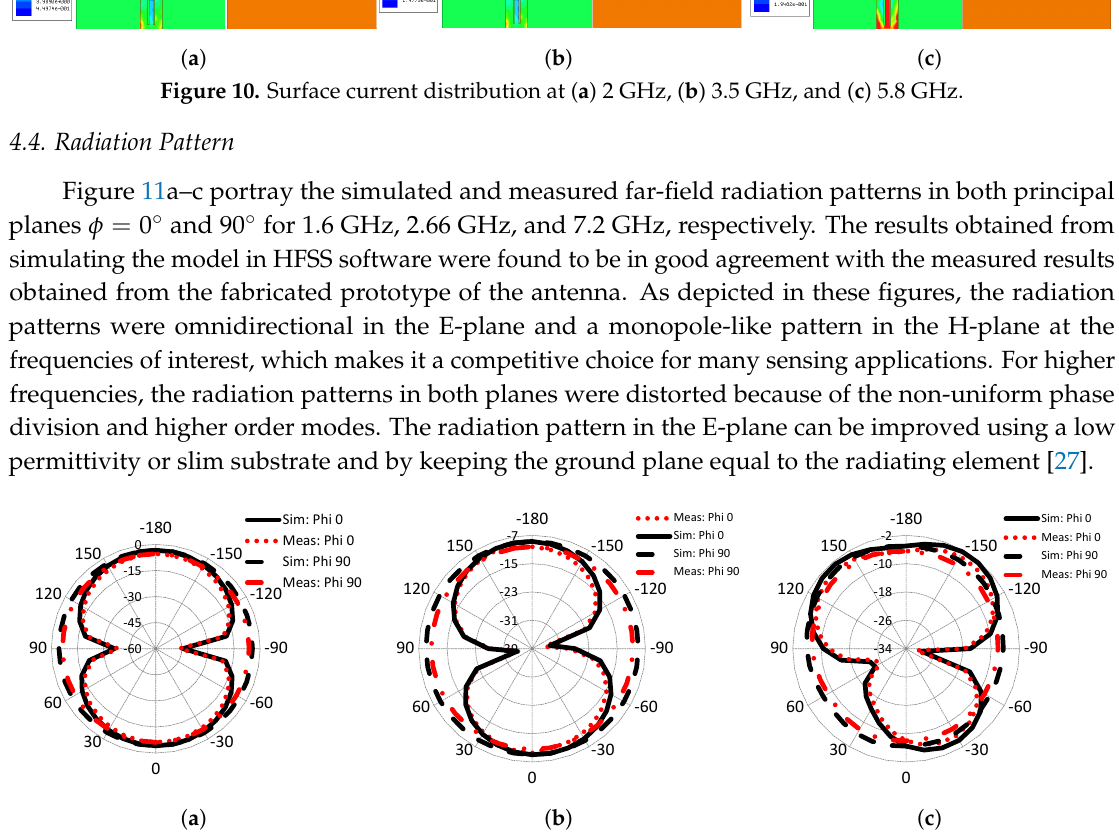
Figure 11. Simulated and measured radiation pattern at ( a ) 1.6 GHz, ( b ) 2.66 GHz, and ( c ) 7.2